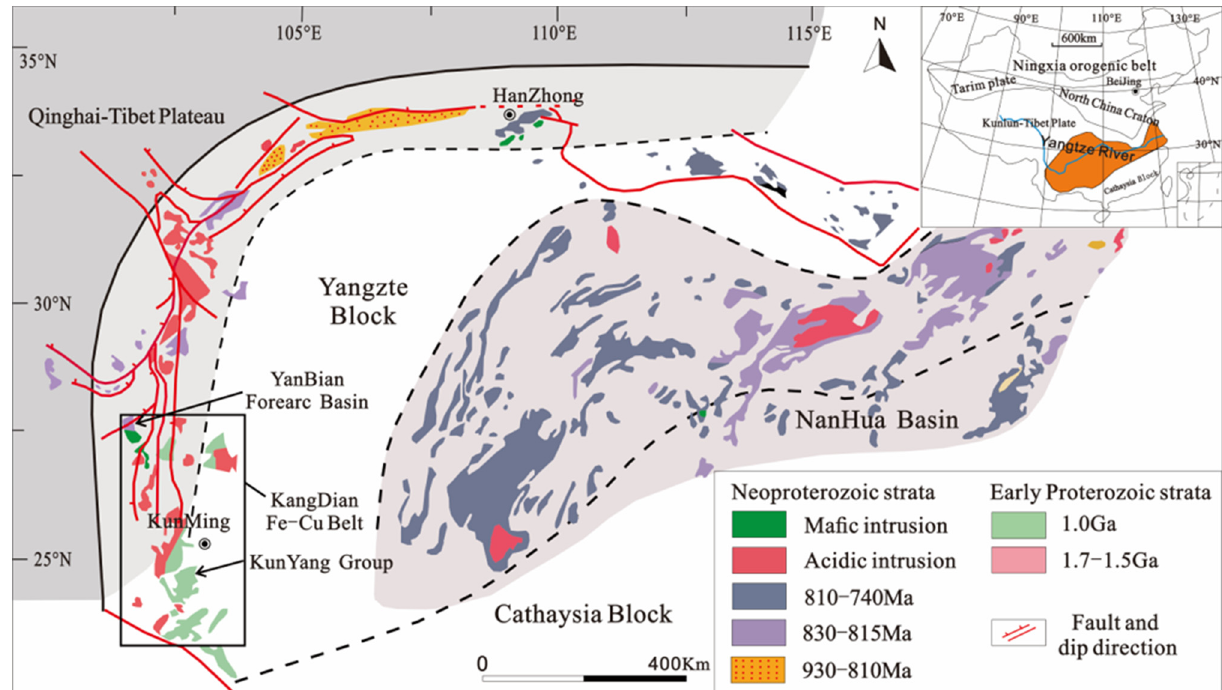
Figure 2. Geotectonic location of the Lala area (modified from [24]).